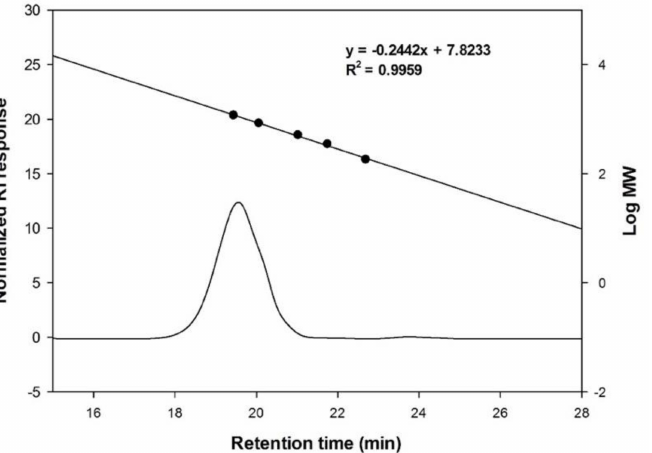
Figure 2. Size exclusion high-performance liquid chromatography (HPLC) of the